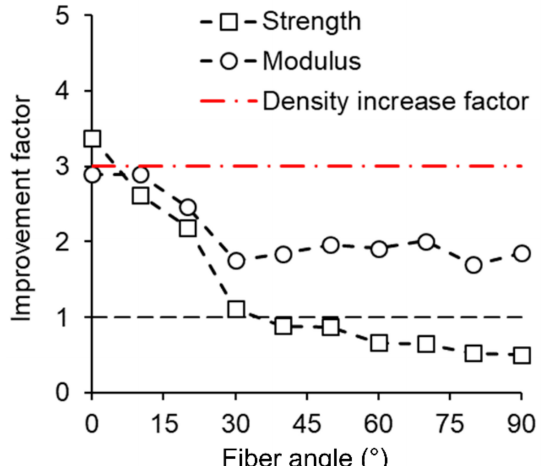
Figure 3. Improvement factor of the mean tensile strength and mean modulus of elasticity of partially delignified and densified wood at di ff erent fiber angles compared to untreated reference